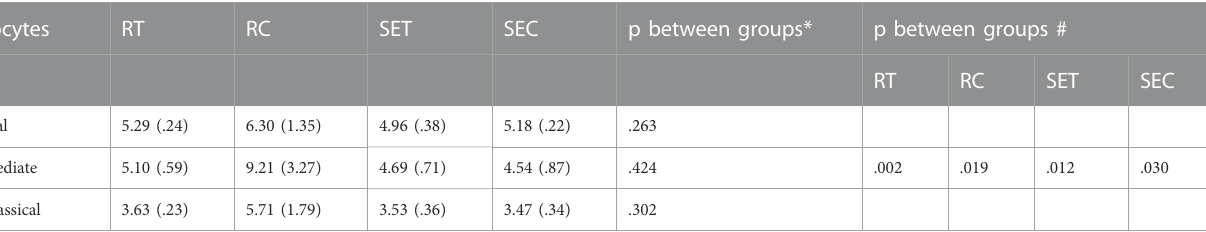
TABLE 9 Level of expression (a.u.) of the receptor CCR5 in monocyte subtypes, according to the treatment arms. Monocytes RT RC SET SEC p between groups* p between groups # Classical